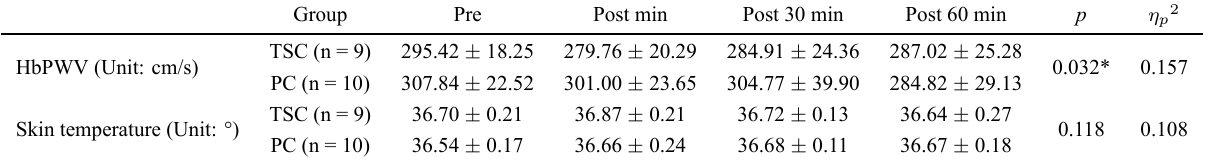
Table 4. Changes in blood flow and skin temperature after topical sports cream